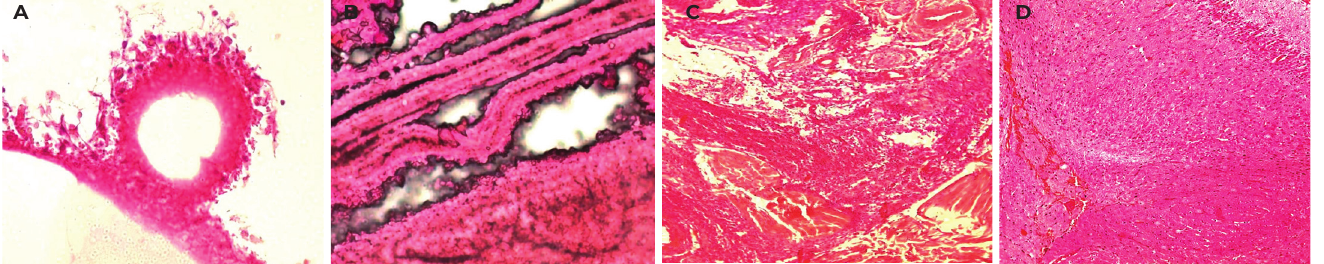
Figure 3 - Echinococcal cyst wall 3 days after HIFU ablation. A - thinning, destruction of germinal layer of the wall and brood capsule of echinococcal cyst. Histological section x 200. B - delamination and necrosis of chitin sheath plates of echinococcal cyst. Histological section x 400. C - granular disintegration of collagenous fibrils of hyaline layer, loosening of outer layer of loose connective tissue. Histological section x 200. D - dystrophy of hepatocytes, rearrangement of hepatic trabeculae, overgrowth of periportal connective tissue of hepatic tissue. Histological section x 200.